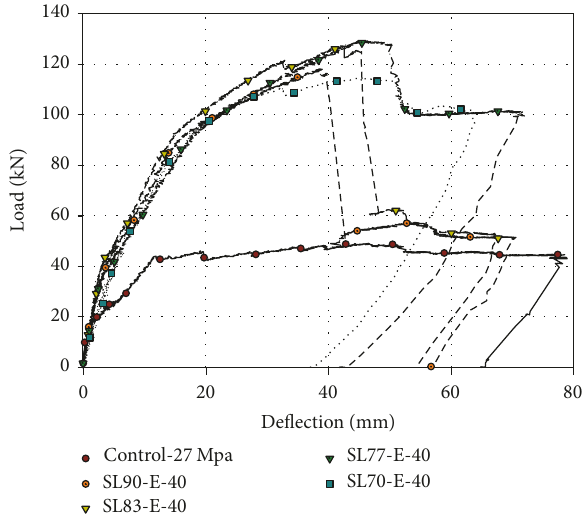
Figure 9: Experimental load-deflection